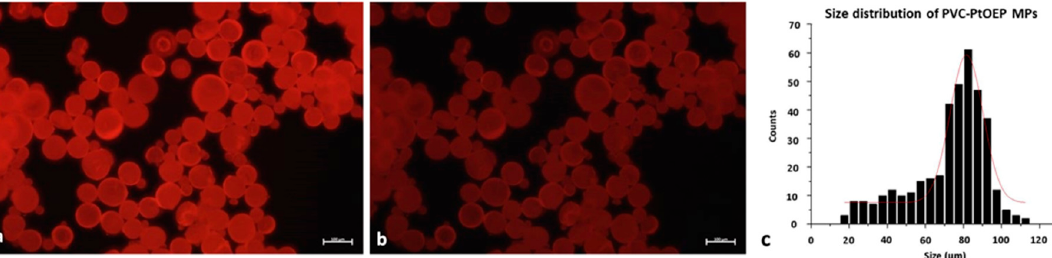
Figure 2. Fluorescent images of PVC-PtOEP MPs irradiate with ( a ) blue and ( b ) green light in the same conditions of illumination and exposure time. Scale bar 100µm. ( c ) represents the size (µm) distribution of PVC-PtOEP MPs.